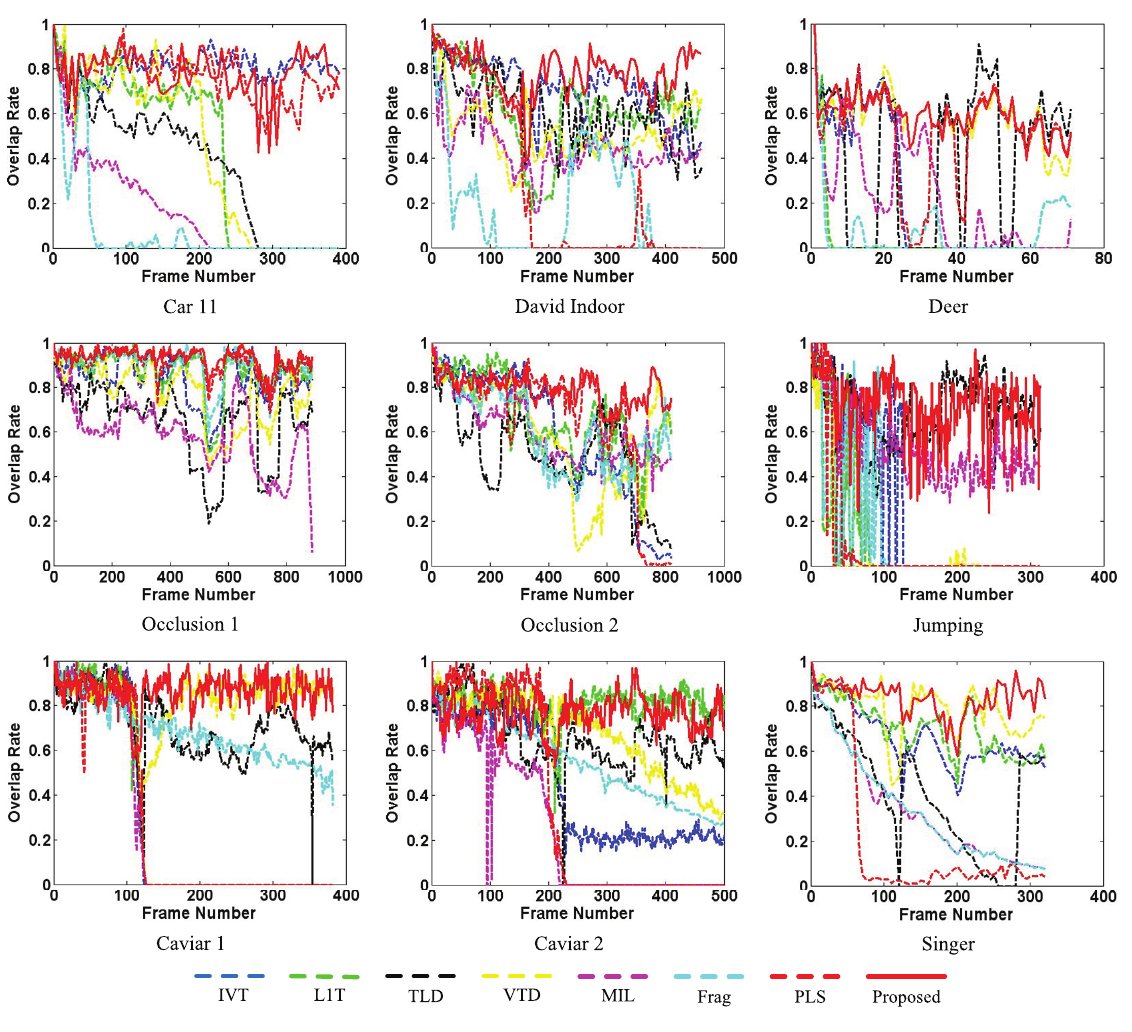
Figure 10. Overlap rate (OR) evaluation for nine video clips. The proposed algorithm is compared with seven state-of-the-art methods: Frag [4], IVT [3], VTD [16], L1T [11], MIL [9], TLD [10] and PLS